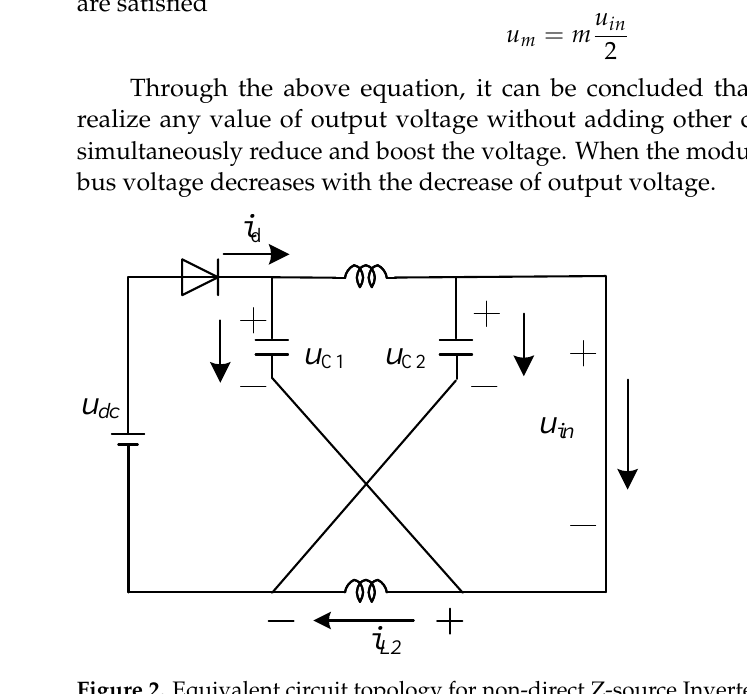
Figure 2. Equivalent circuit topology for non-direct Z-source Inverter.